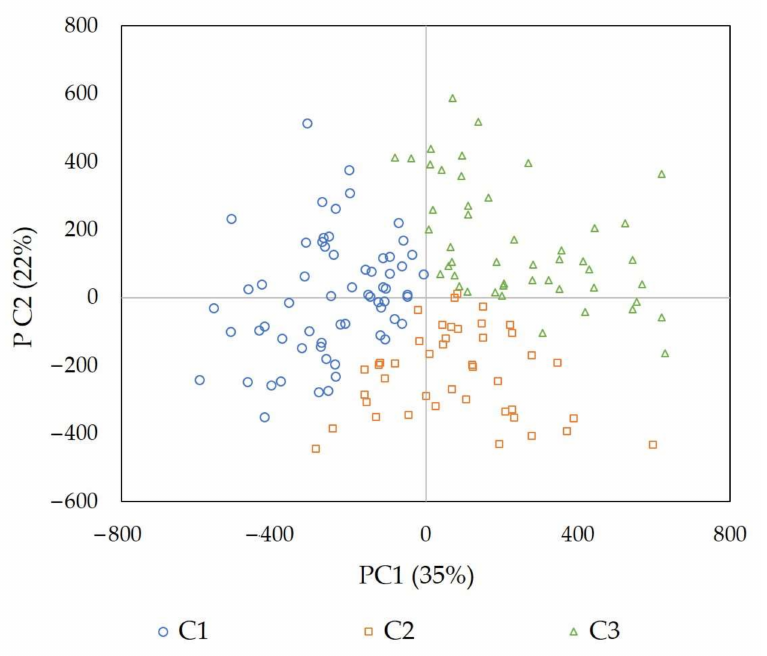
Figure 4. Clustering of samples by K-means represented in the PCA score-plot. Figure 5 presents the linear-plot of the PCA loadings for PC-1, PC-2 (Figure 5a), and PC-6 (Figure 5b). It is observed that the reflections of the main mineral in the bauxite (gibbsite) have greater effect on PC-1 whilst PC-2 is more influenced by noise from low angles. The variability related to kaolinite were most extracted by